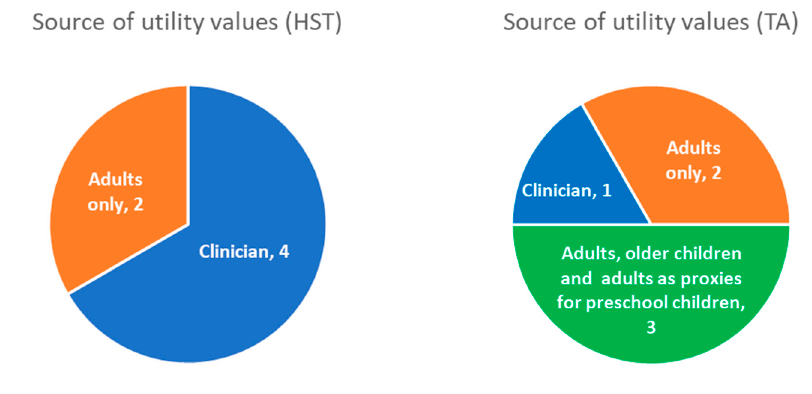
Figure 3. Sources of utility values used for preschool children in NICE appraisals.